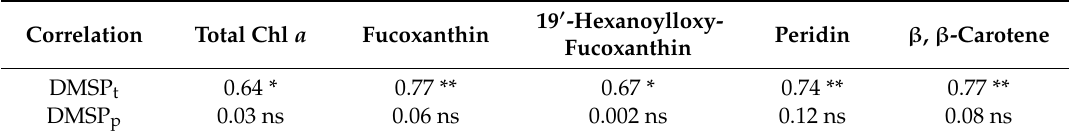
Table 3. Dimethylsulfoniopropionate (DMSP) and phytoplankton pigment correlations inside patch over Lagrangian